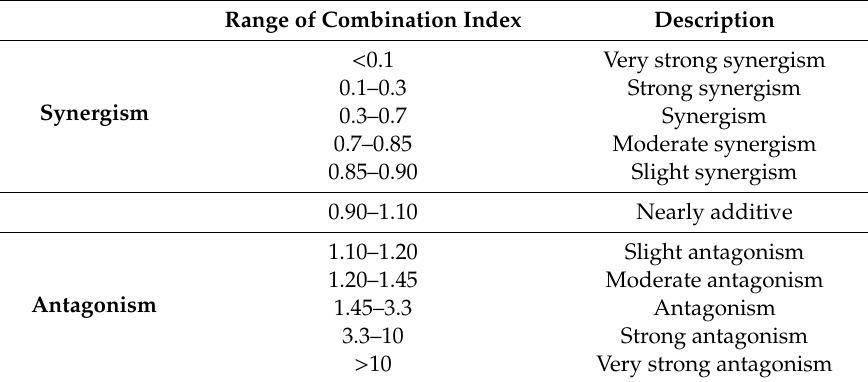
Table 5. The scales of combined e ff ects by using the log(CI)